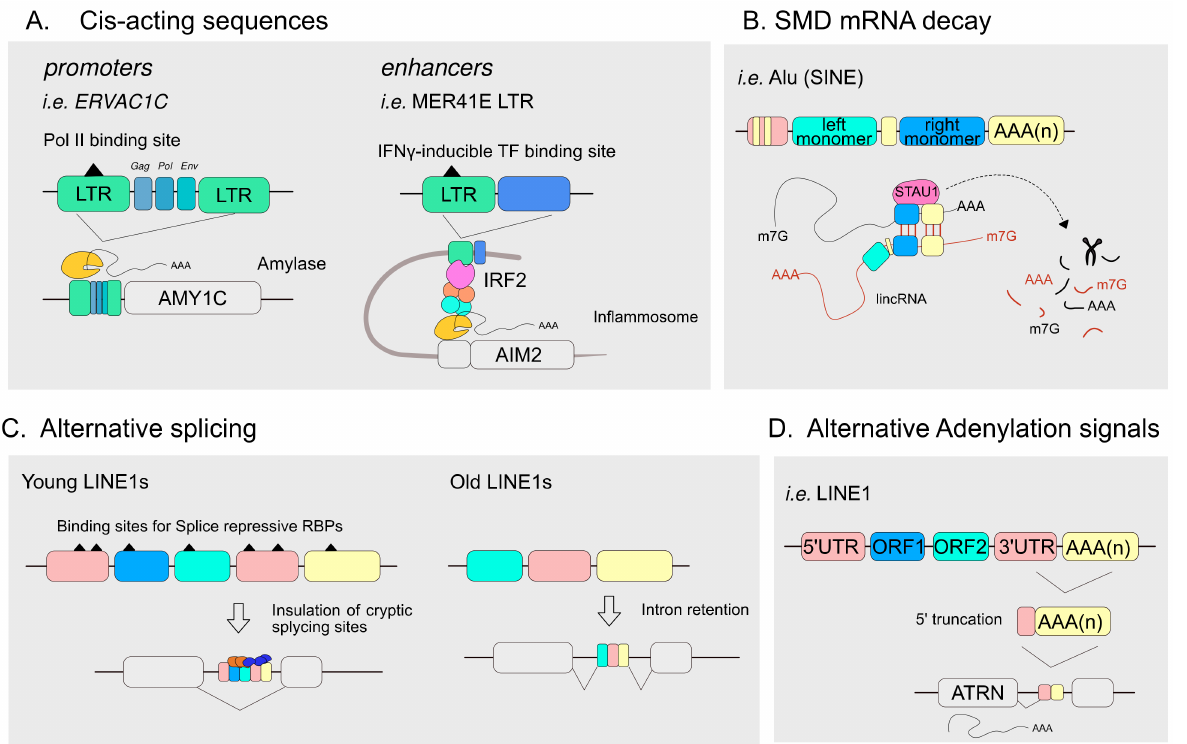
Figure 3. Examples of TEs-mediated regulatory functions. Schematic representation of ( A ) AMY1C regulation owed to the insertion of Endogenous retrovirus ERVA1C that acts as a tissue-specific promoter (left), MER41 carries consensus sequences for transcription factors and acts as an enhancer, recruiting IRF2 to trigger the assembly of AIM2 (right); ( B ) Cytosolic adenylated lncRNAs contain- ing Alu (lincRNA) imprecisely pair to SMD-target poly-adenylated mRNAs to generate dsRNA, recognized by STAU1 protein that initiates the degradation cascade ( C ) Young LINE1 elements harbor consensus sequences for repressive-splice RBPs (right), old evolutionary LINE1s have a higher probability of being intron-retained and generating alternative splicing-isoforms (left). ( D ) The human isoform ATRN derives from a 5 (cid:48) truncated LINE1 element that retains a stop codon and a polyadenylation